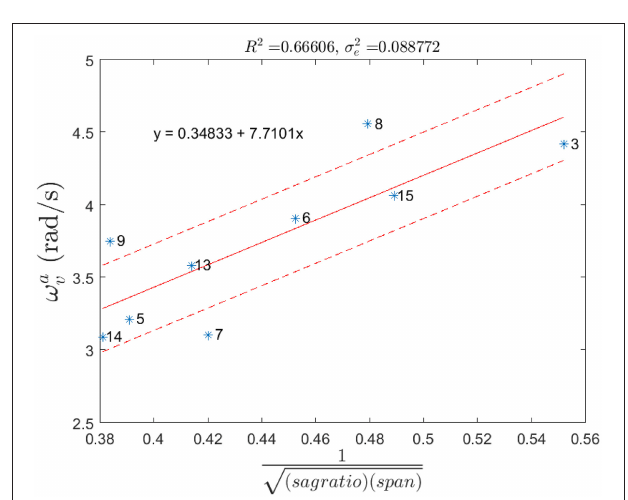
FIGURE 13 | Measured VA frequencies (*), empirical formula (solid line) and standard deviation of prediction error (dashed) along with the formula.